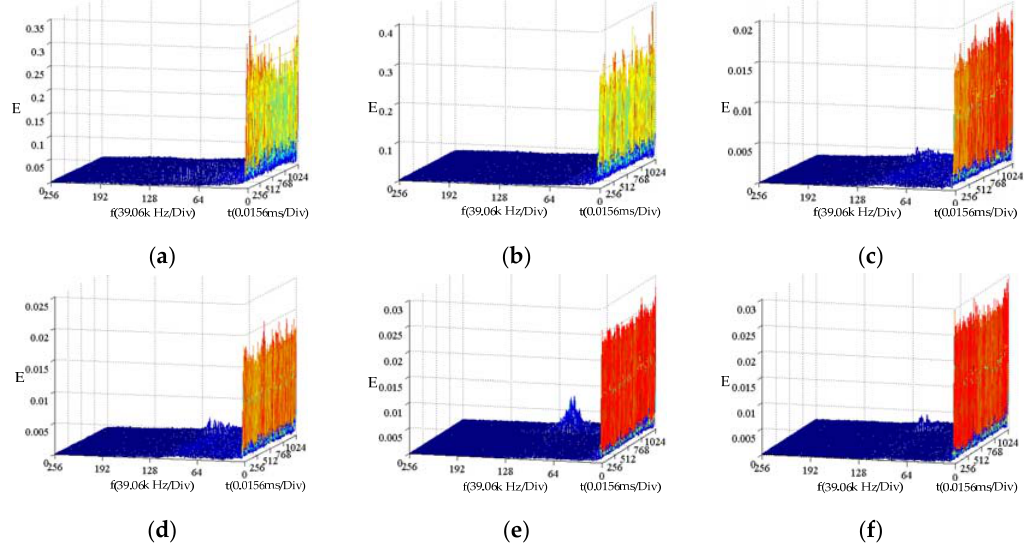
Figure 10. Time–frequency–energy 3D spectrums by HHT for ( a ) Type I ( b ) Type II ( c ) Type III ( d ) Type IV ( e ) Type V ( f ) Type VI.